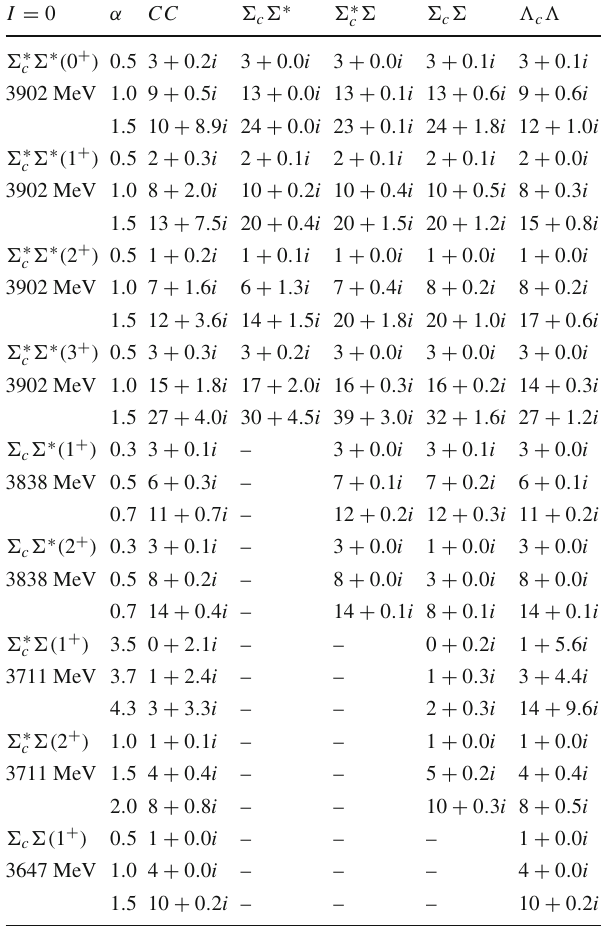
Table 4 The masses and widths of isoscalar charmed-strange molecu- lar states at different values of α . The “ CC ” means full coupled-channel calculation. The values of the complex position means mass of corre- sponding threshold subtracted by the position of a pole, M th − z , in the unit of MeV. The two short line “–” means the decay channel does not exist. The imaginary part shown as “0 . 0” means too small value under